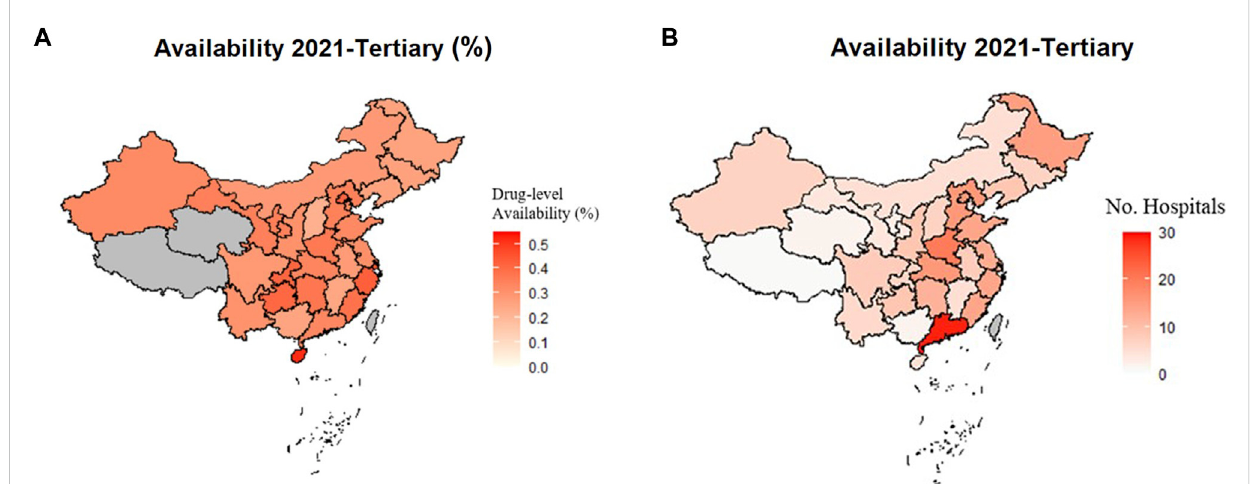
FIGURE 2 Availability of Orphan Drugs in Tertiary Hospitals in 2021 by Province. Greyed areas represent the excluded results due to data not collected or total number of hospitals under fi ve. (A) Availability at drug-level in tertiary hospitals by percentage in each province in 2021. (B) Availability at drug-level in tertiary hospitals by number of hospitals in each province in 2021.